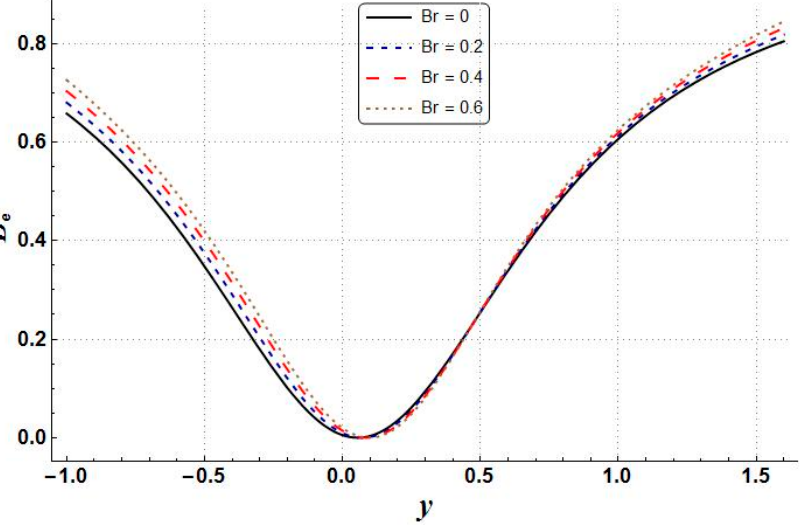
Figure 36. Influence on B e through changing values of Br , where γ = π φ = 0.05, k = 2, a = 0.6, M = 1, d = 0.7, m = 1, b = 0.5, ∈ = 2, η =